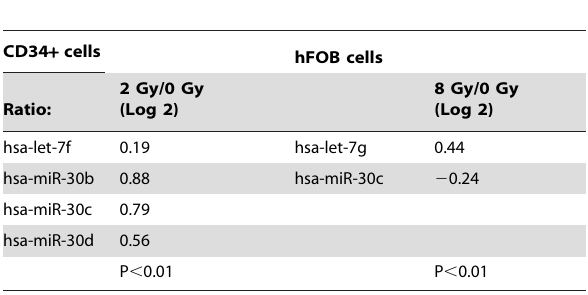
Table 1. Radiation regulated miRNAs expression in both CD34 + and hFOB cells.